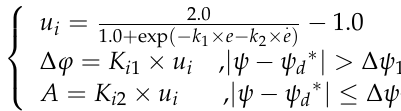
Figure 5. Block diagram of the course controller. is the final desired heading angle; i